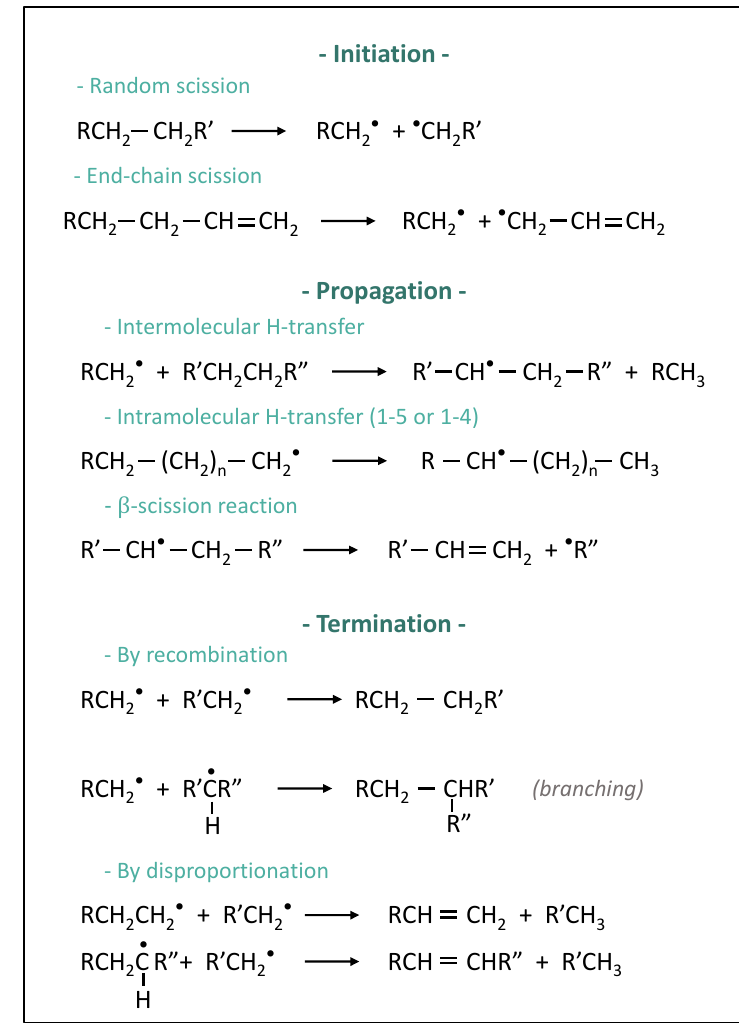
Figure 1. Simplified mechanisms of thermal degradation of polyethylene [23,24].